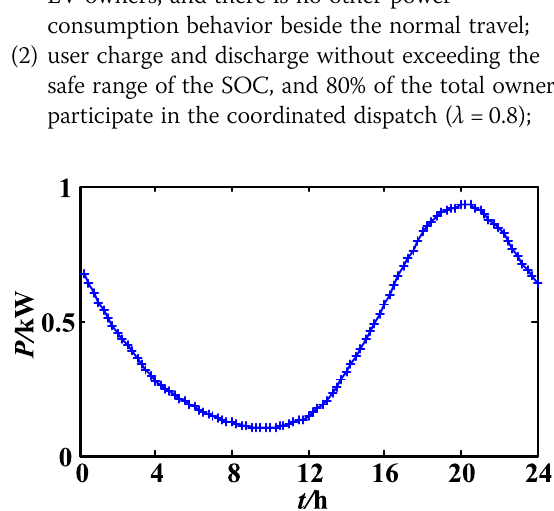
Fig. 3 Original charging requirement for a single